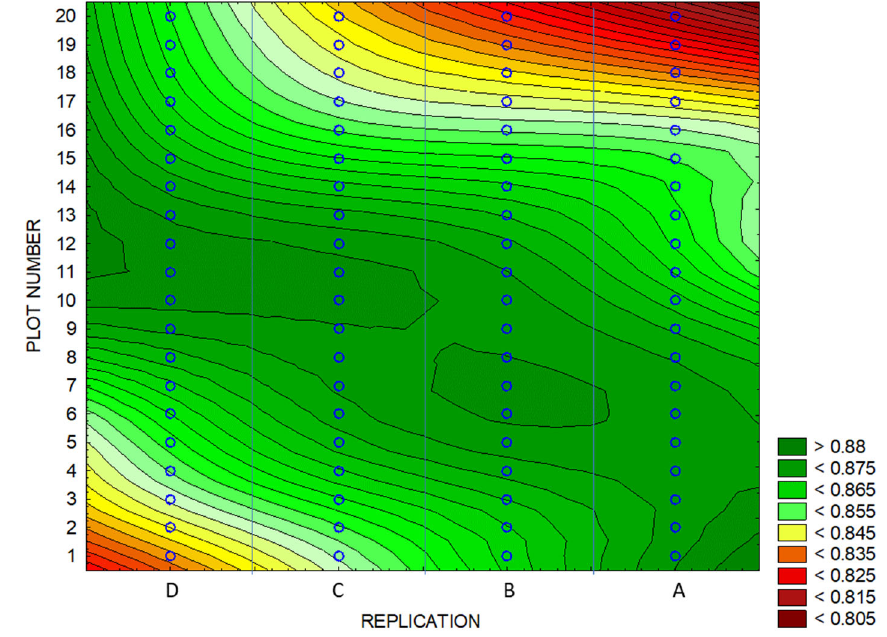
Figure 15. Contour map of BNDVI. Blue circles illustrate plot centers.